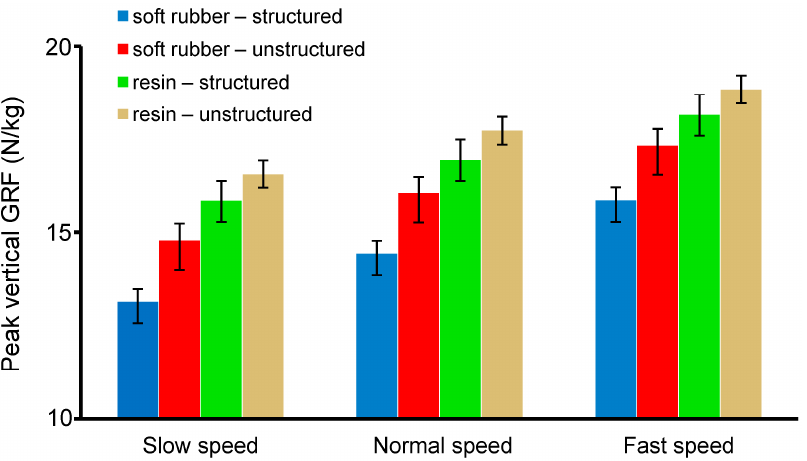
Figure 10. Mean and deviations of the peak vertical GRF of the four bionic heel pads during human walking at different speeds, n = 5.